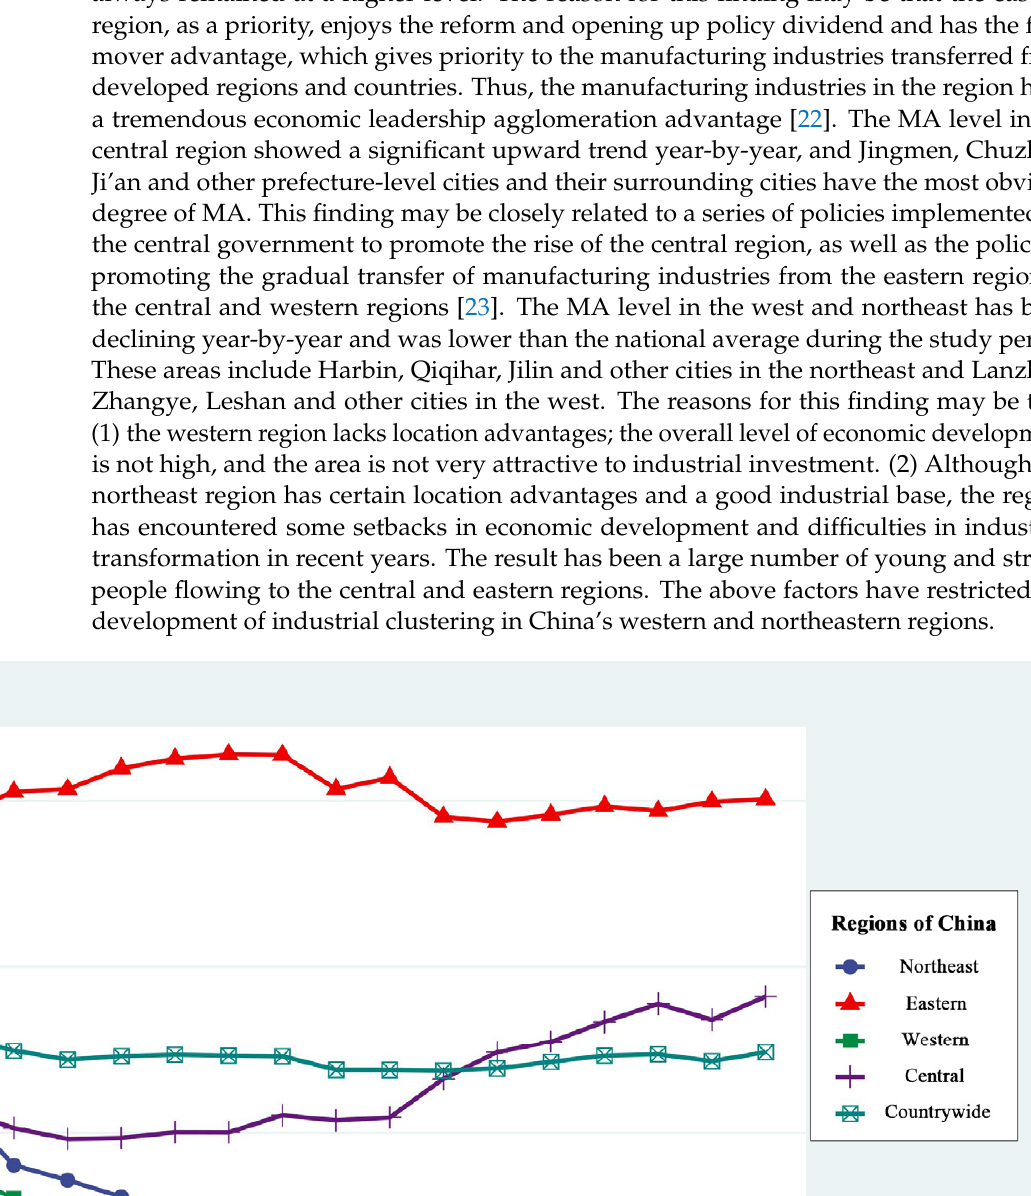
Figure 2. Spatial distribution of MA in Chinese Cities from 2004–2019. 3.1.2. Measurement Results and Spatio-Temporal Analysis of GUEIL Figure 3 reflects the changes in GUEIL in China and its regions from 2004 to 2019, while Figure 4 shows the spatial distribution of GUEIL in Chinese cities during those years. One can find that the overall level of GUEIL nationwide shows a trend of first in- creasing, then slightly decreasing and then increasing. There was a general trend of in- creasing efficiency from 2004–2012 and a slight decrease in efficiency from 2012–2015. The reason may lie in the following: the large-scale construction of industrial parks and indus- trial zones in various regions has resulted in the rapid expansion of industrial land, but the lack of industrial imports has left much industrial land idle and inefficient. In addition, the low price of land resources acquired by enterprises will inevitably lead to the